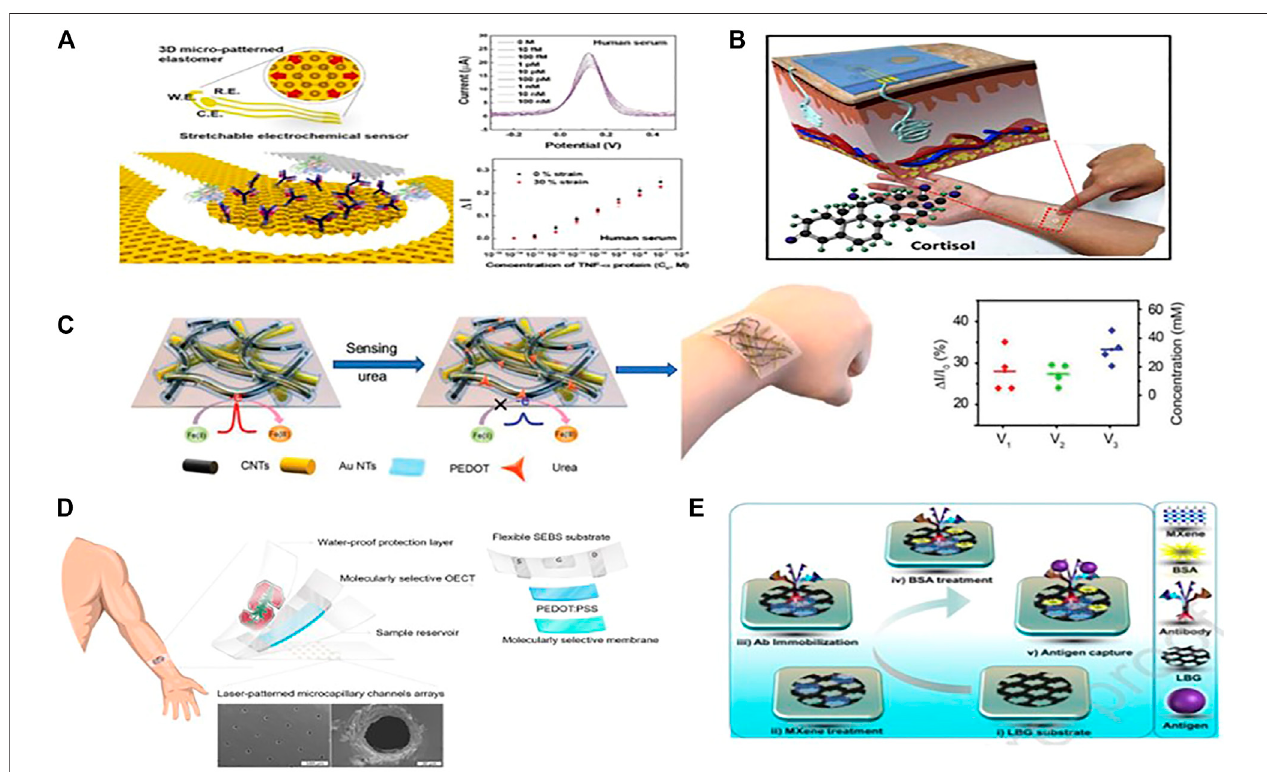
FIGURE 8 | Schematic diagrams of electrochemical immunosensors. (A) 3-D micro-patterned elastomeric substrate-based Stretchable electrochemical immunosensor. (Copyright 2019; Sensors and Actuators). (B) LOP with micro fl uidic and electrochemical sensing components for wearable POCT, as well as a schematicdiagramoftheLOPplatformforwearablebiomarkerdetection,fabricatedonamogul-patternedsubstratewith3-DnanostructuredAuasaworkingelectrode (Copyright 2020; Biosensors and Bioelectronics). (C) the development of a fl exible sensor for the electrochemical detection of urea (Copyright 2018; American Chemical Society). (D) A patch-type wearable cortisol sensor based on carbon nanotubes and a lightweight SEBS elastomer substrate with a PEDOT:PSS semiconductor layer and an MSM. (Copyright 2018; Science Progresses.). (E) a Ti 3 C 2 T x MXene-loaded laser-induced graphene cortisol immunosensor (Copyright 2021; Sensors and Actuators).